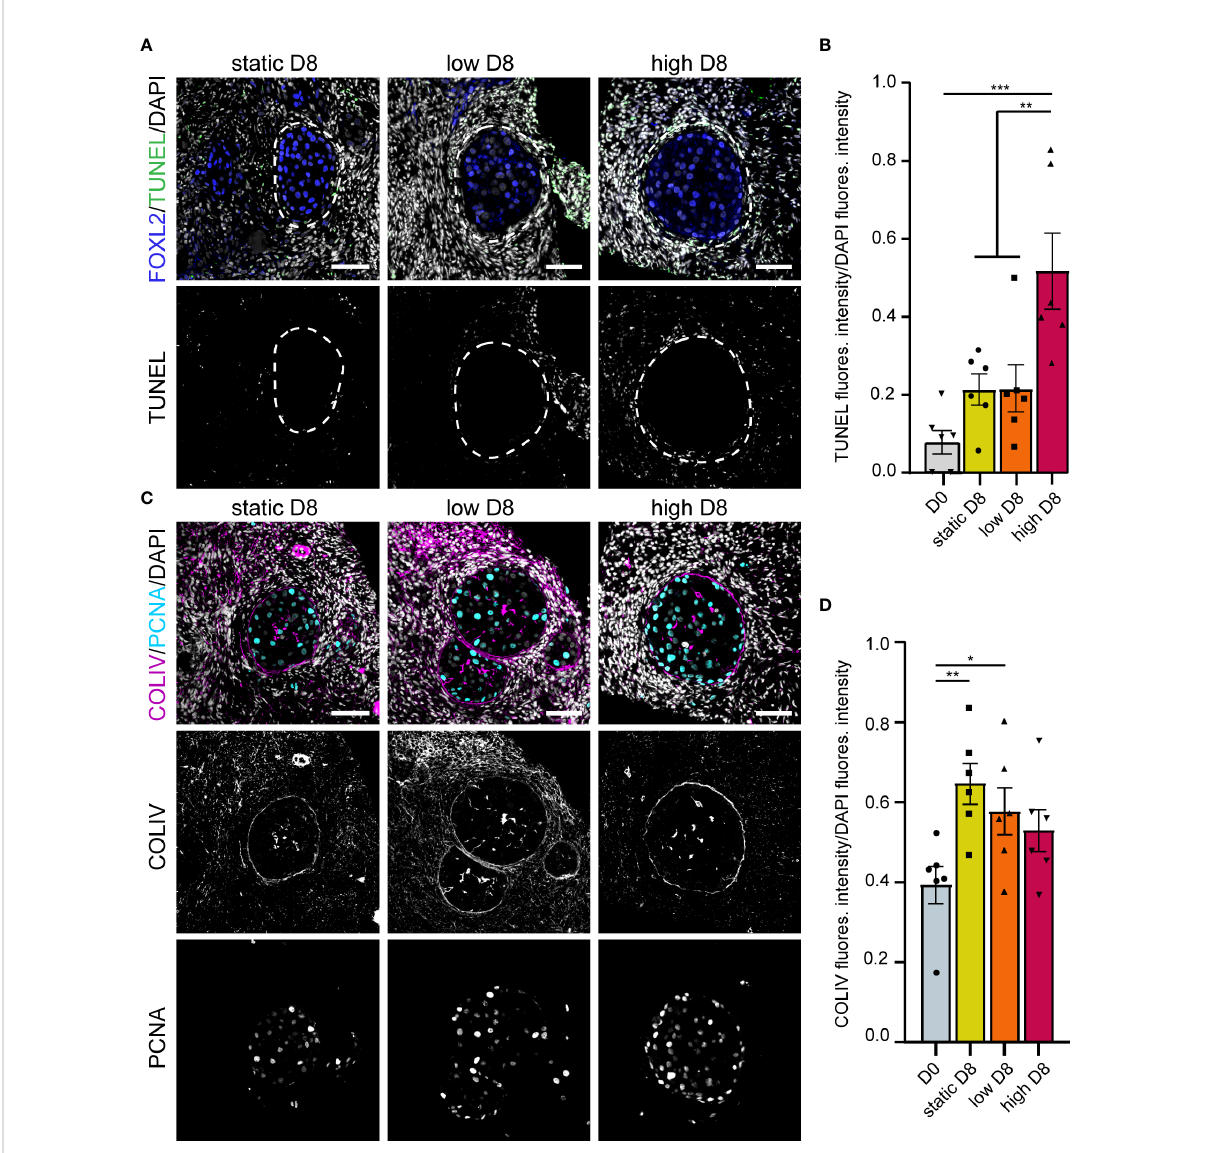
FIGURE 6 Apoptosis, proliferation and COLIV deposition in ovarian cortical cubes after eight days of culture. (A) Immuno fl uorescence for FOXL2 together with TUNEL assay in secondary follicles after eight days (D8) culture in static, low and high fl ow rate. Scale bars= 50 m m. (B) Relative TUNEL fl uorescence intensity in ovarian cortical cubes at D0 and after D8 culture in static, low and high fl ow rate. Statistical analysis was performed using one-way ANOVA followed by Fisher test (** = p_value < 0.01; (*** = p_value < 0.001). (C) Immuno fl uorescence for COLIV and PCNA in secondary follicles after D8 culture in static, low and high fl ow rate. Scale bars= 50 m m. (D) Relative COLIV fl uorescence intensity in ovarian cortical cubes at D0 and after D8 culture in static, low and high fl ow rate. Statistical analysis was performed using one-way ANOVA followed by Fisher test (* = p_value < 0.05; ** = p_value <